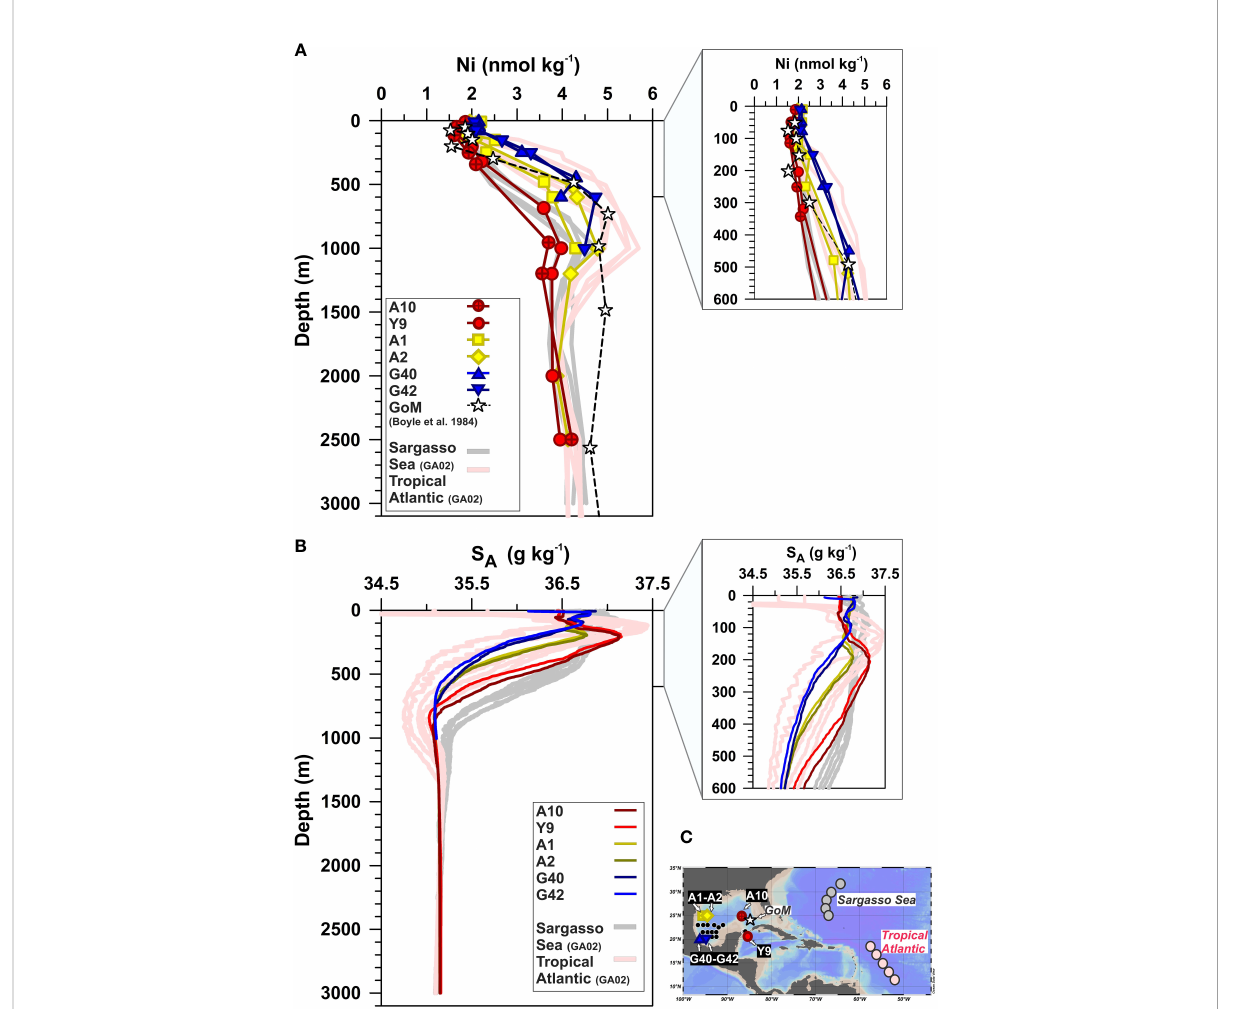
FIGURE 6 Vertical pro fi les of (A) dissolved Ni and (B) absolute salinity (S A ) during the XIXIMI-6 cruise. For comparison, the vertical pro fi les of dissolved Ni reported for the eastern GoM (Boyle et al., 1984; star symbols), as well as the dissolved Ni and S A in the North Atlantic (Sargasso Sea and Tropical North Atlantic) from the GEOTRACES GA02 transect (Schlitzer et al., 2018; Middag et al., 2020) are included in (A, B) , respectively. The locations of the sampling stations are shown on the map (C) . Note that pro fi les of dissolved Ni (A) and S A (B) in the upper 600 m are enlarged to improve